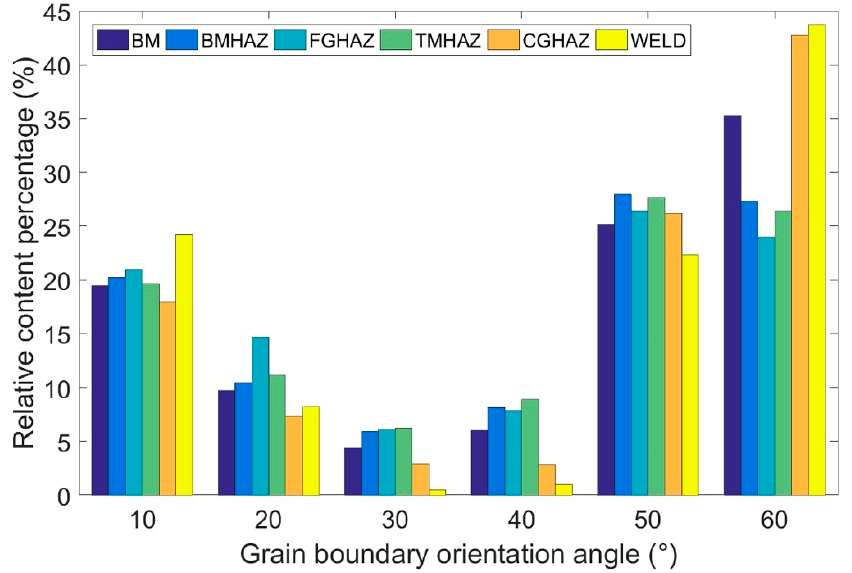
Figure 7. Distribution of the grain boundary misorientation in the X100 laser-welded joint from the BM to the WELD.